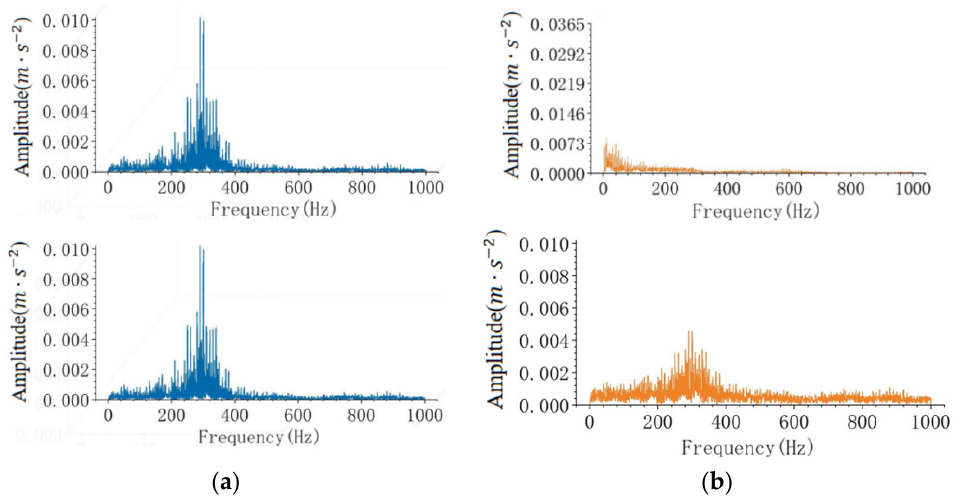
Figure 9. Sparse decomposition simulation amplitude/envelope results. ( a ) sparse decomposition amplitude spectrum, and ( b ) sparse decomposition envelope spectrum.